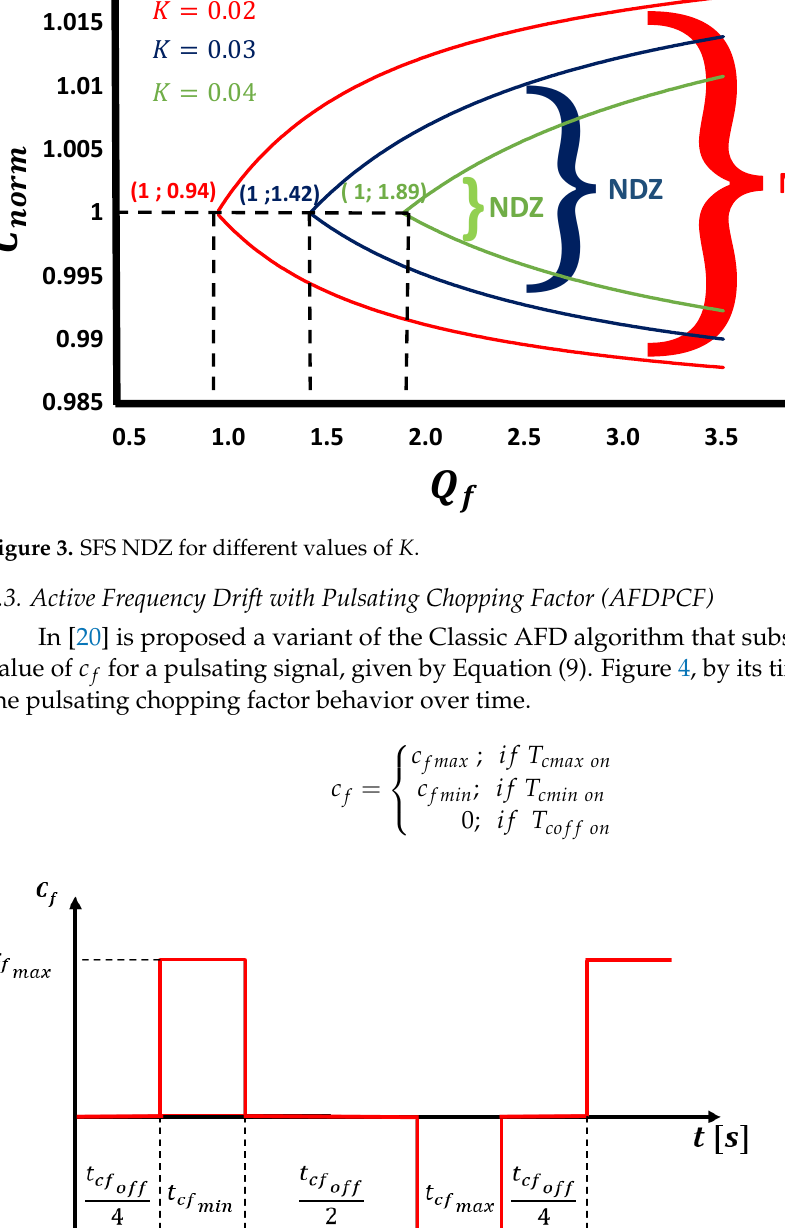
Figure 4. 𝑐 𝑓 behavior during the AFDPCF operation.